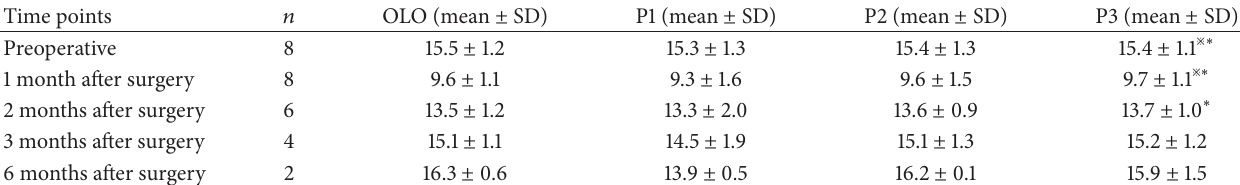
Table 1: Comparison of IOP measurements between the Ologen group and PTLGA terpolymer groups.